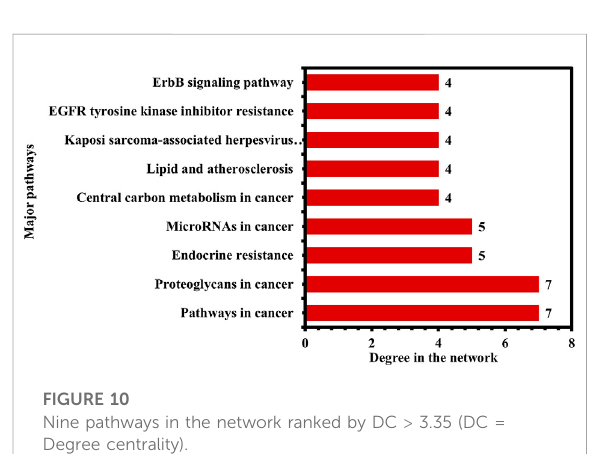
FIGURE 10 Nine pathways in the network ranked by DC > 3.35 (DC = Degree centrality).